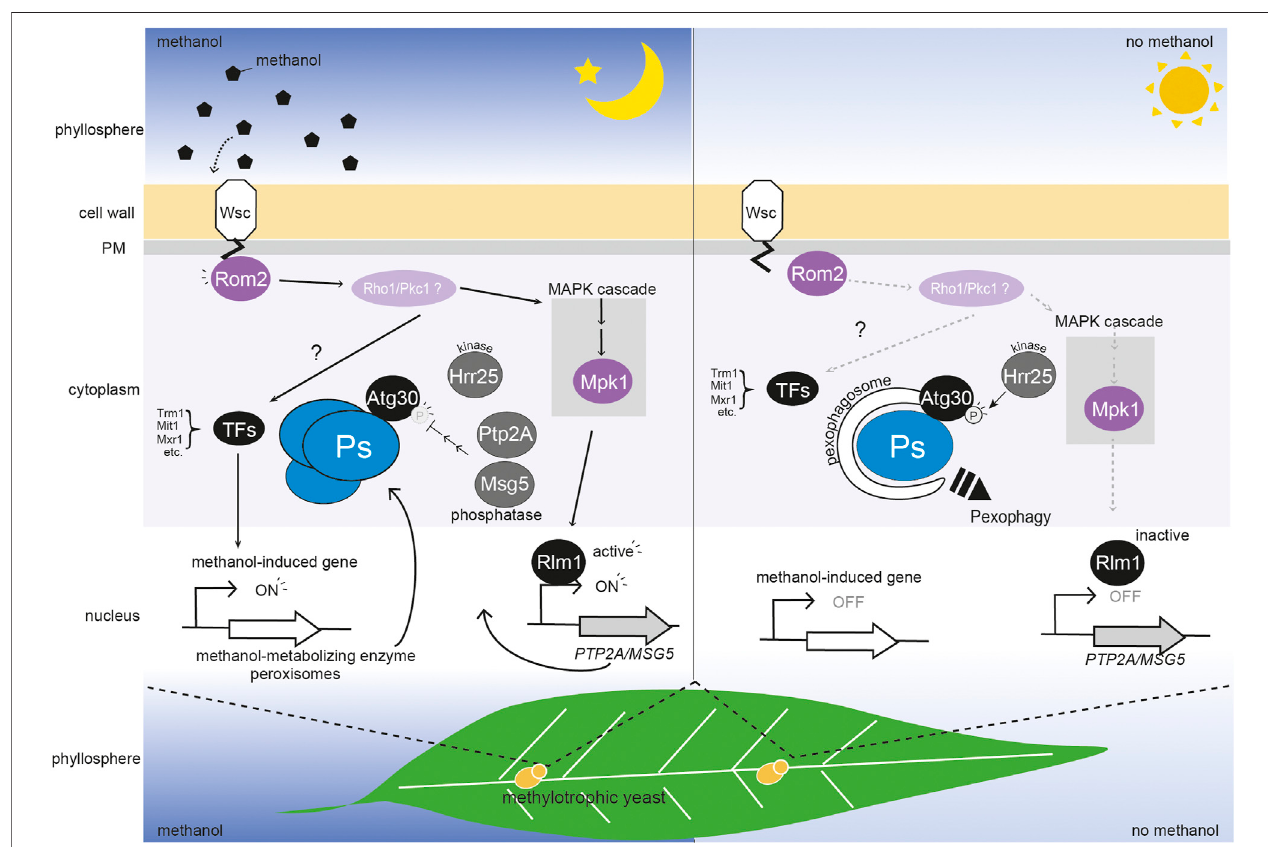
FIGURE 1 | Regulation of peroxisome homeostasis by a methanol-sensing pathway mediated by WSC family proteins in the phyllosphere. WSC family proteins (Wsc1 and Wsc3) sense the change in methanol concentration, and transmit a signal to Rom2 which is then transmitted via two unidenti fi ed molecules (possibly Rho1 and Pkc1) to the transcription factors (TFs) Trm1, Mit1, and Mxr1. The transcription factors activate methanol-induced genes and this results in peroxisomes (Ps) biogenesis (Lin-Cereghino et al., 2006; Parua et al., 2012; Sahu et al., 2014; Wang et al., 2016; Ohsawa et al., 2018). Simultaneously, the methanol signal under Wsc1 and Rom2 is transmitted to the MAPK cascade, which includes Mpk1. The transcription factor, Rlm1 then represses pexophagy via expression of two phosphatases, PTP2A and MSG5, whichregulatethelevelofphosphorylation(P)oftheAtg30 pexophagyreceptor.Asdepletionofmethanolreleases thebiogenesisof peroxisomes and repression of pexophagy, the phosphorylation of KpAtg30 by Hrr25 is enhanced (Zientara-Rytter et al., 2018). In the phyllosphere, plant leaf methanol concentration oscillates diurnally, being higher in the dark period and lower in the light period (~0 – 0.3%) (Kawaguchi et al., 2011). In the dark period (left panel) , methanol enhances induction of peroxisome biogenesis and represses pexophagy. In the light period (right panel) , methanol-induced gene expression is low, and peroxisomes are degraded via pexophagy.